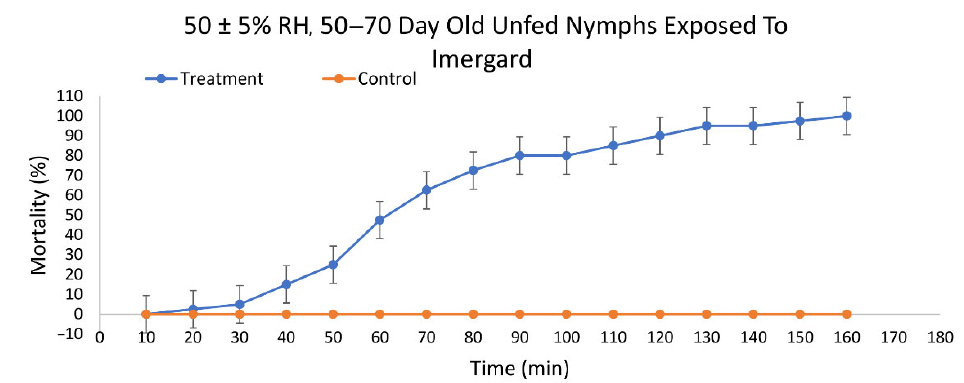
Figure 3. Mortality over time of unfed nymphal Ixodes scapularis ticks 50–70 days past last molt ex ‐